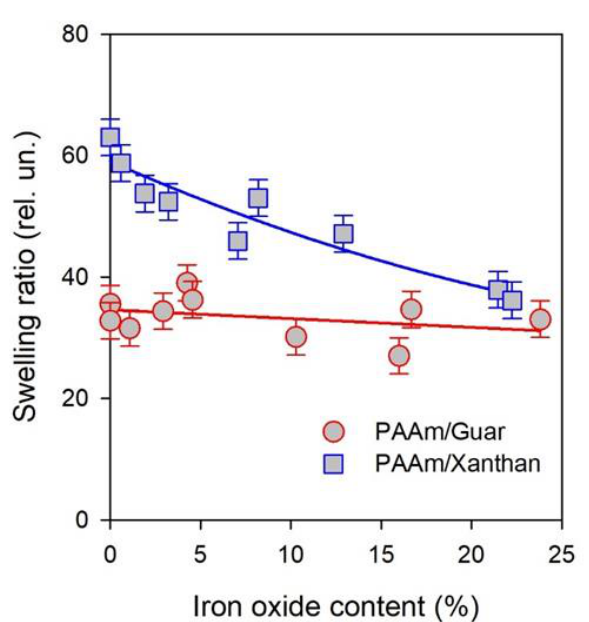
Figure 5. Dependence of swelling ratio of FG in PAAm/Guar and PAAm/Xanthan series on the content of iron oxide MPs. Lines are given for an eye-guide only.